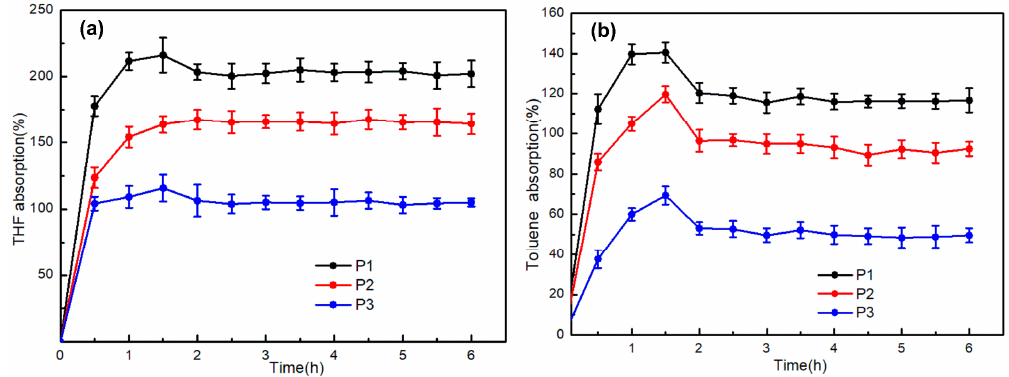
Figure 9. Solvent-swelling of three films: ( a ) THF absorption-time diagram; ( b ) toluene absorption-time diagram.